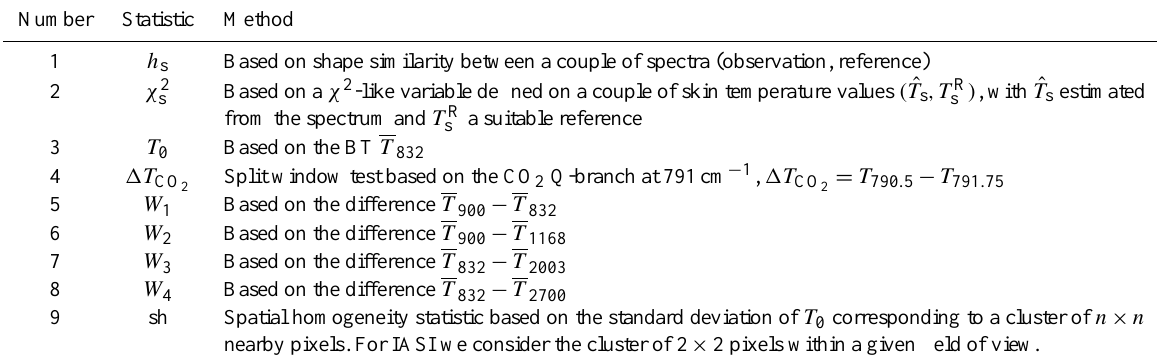
= T − T 790 . 5 791 . 75 2